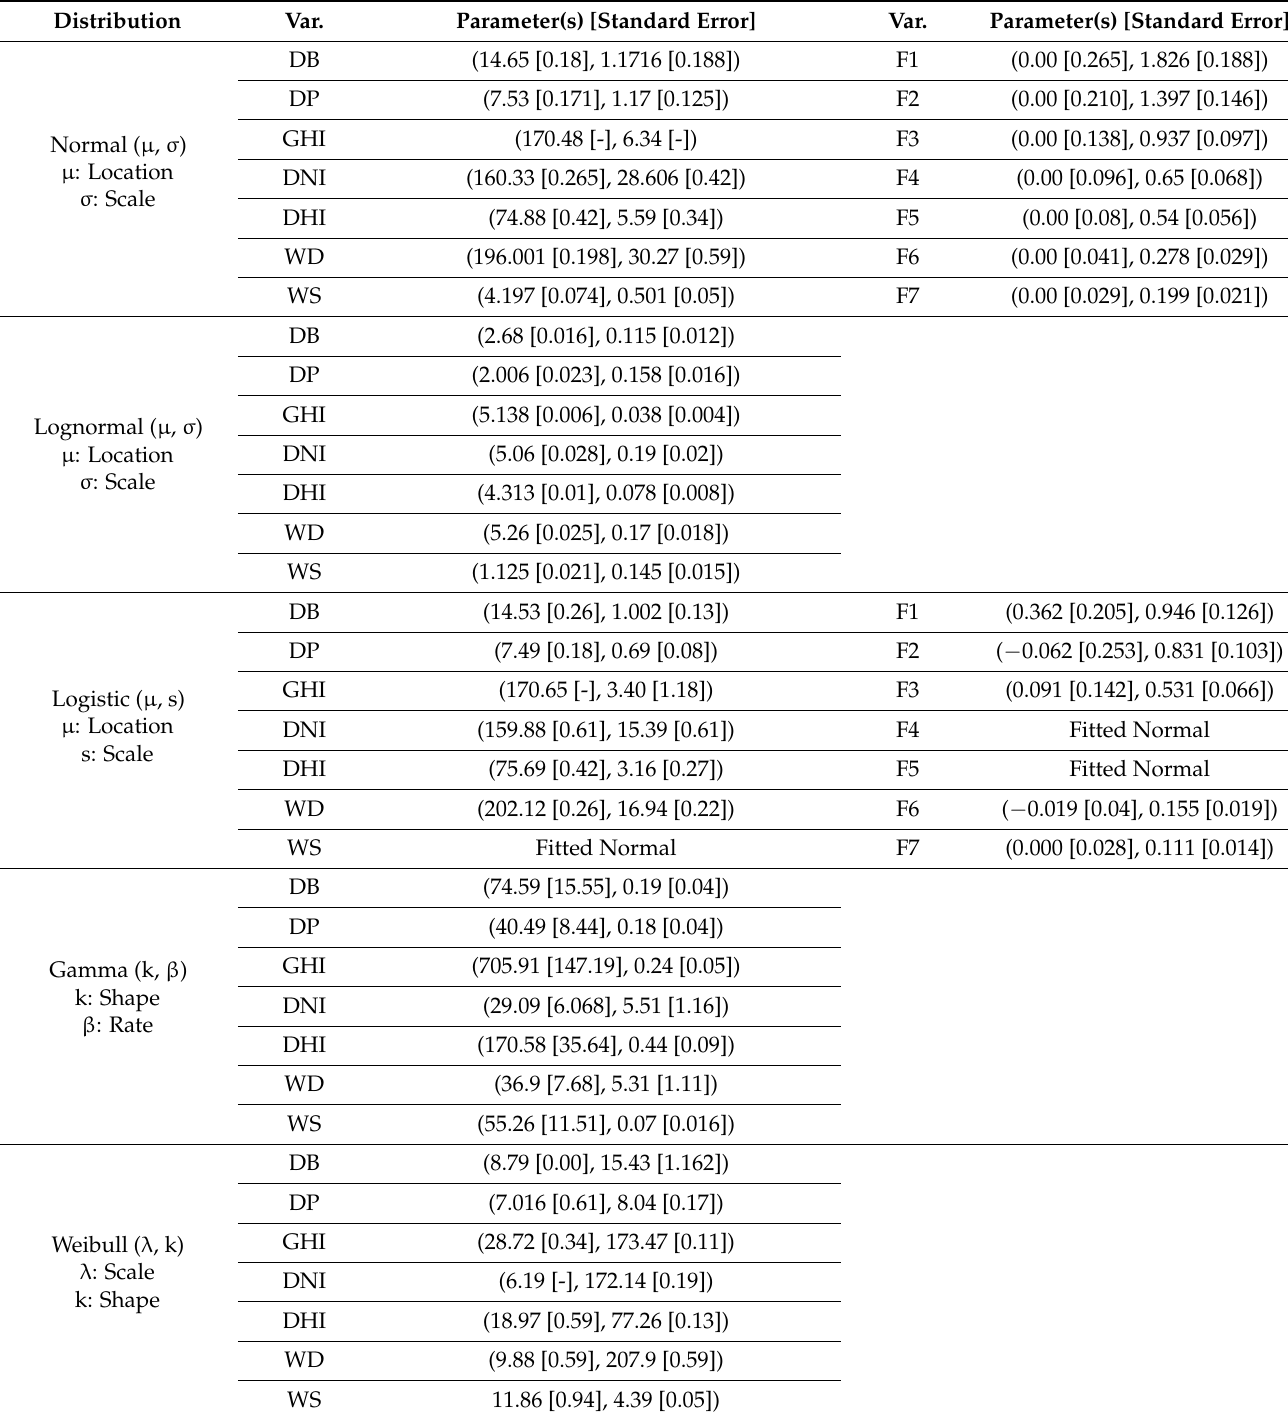
Table A6. Details of the average annual weather variables distributions and their associated principal component distribu- tions used in this